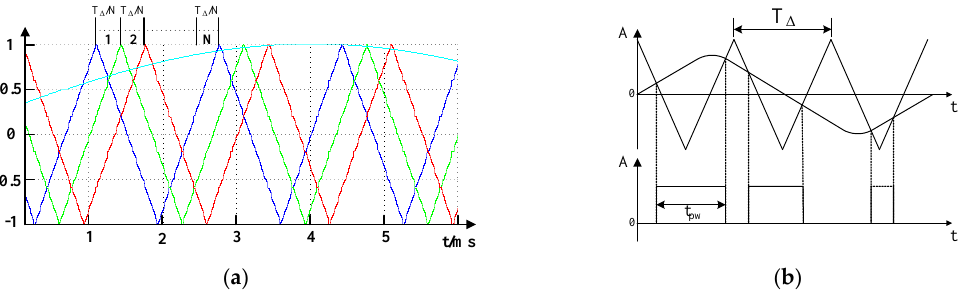
Figure 4. Modulation: ( a ) Carrier phase-shifted modulation (Different colors represent different carriers); ( b ) sine pulse width modulation.